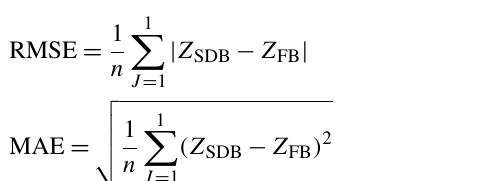
Table 2. R 2 , RMSE and MAE of the estimated